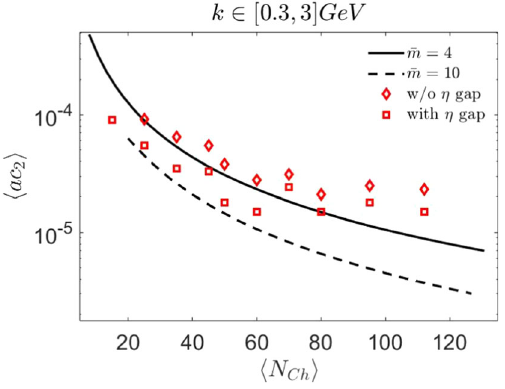
Fig. 14 The 3 point cumulant ac 2 averaged over region 0 . 5 < k i < 3 and 0 . 5 < k i < 3 (i=1,2,3), compared with experimental data. The experimental data is depicted after additional analysis [35] of the ATLAS results, made to minimize nonflow effects, where the two types of experimental points correspond to analysis with or without the gap of 0.5 units between